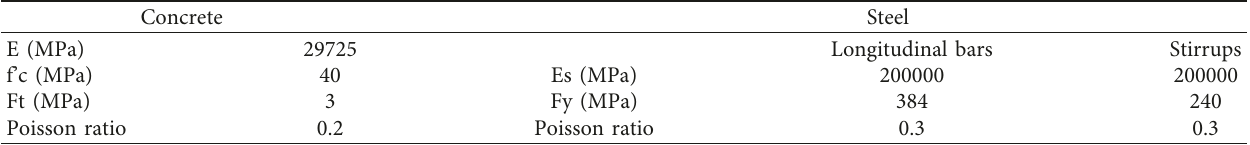
Figure 4: Curved RC beam test specimen for FE simulation validation [32]. (a) Geometric dimension of test specimen and (b) cross- sectional dimension with detailing. Table 5: Material properties of test specimen used for FE simulation